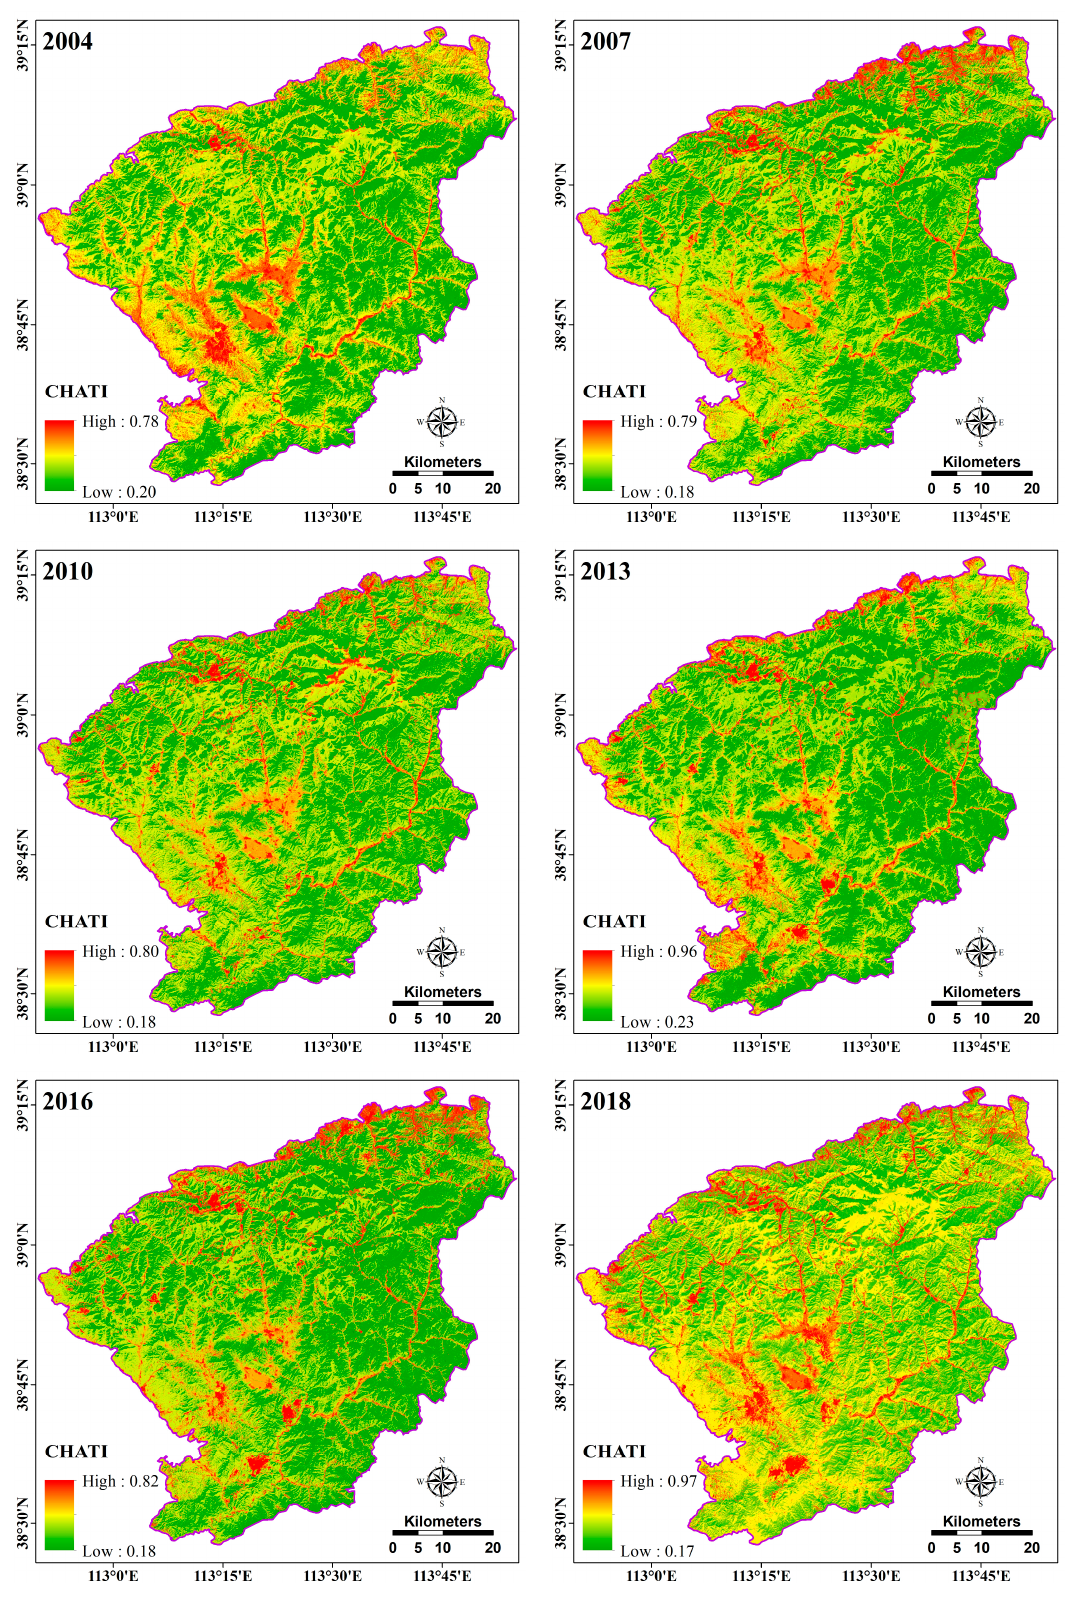
Figure 15. The CHATI from 1987 to 2018.